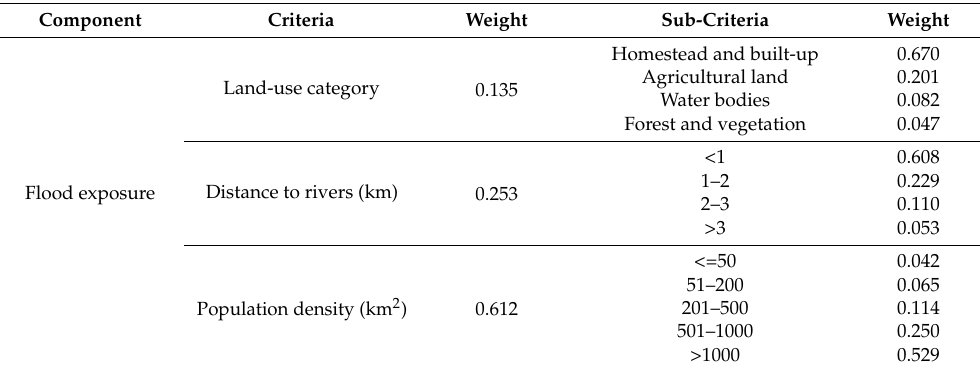
Figure 5. Distribution of flood exposure criteria and sub-criteria. Table 2. Decision hierarchy model for flood exposure